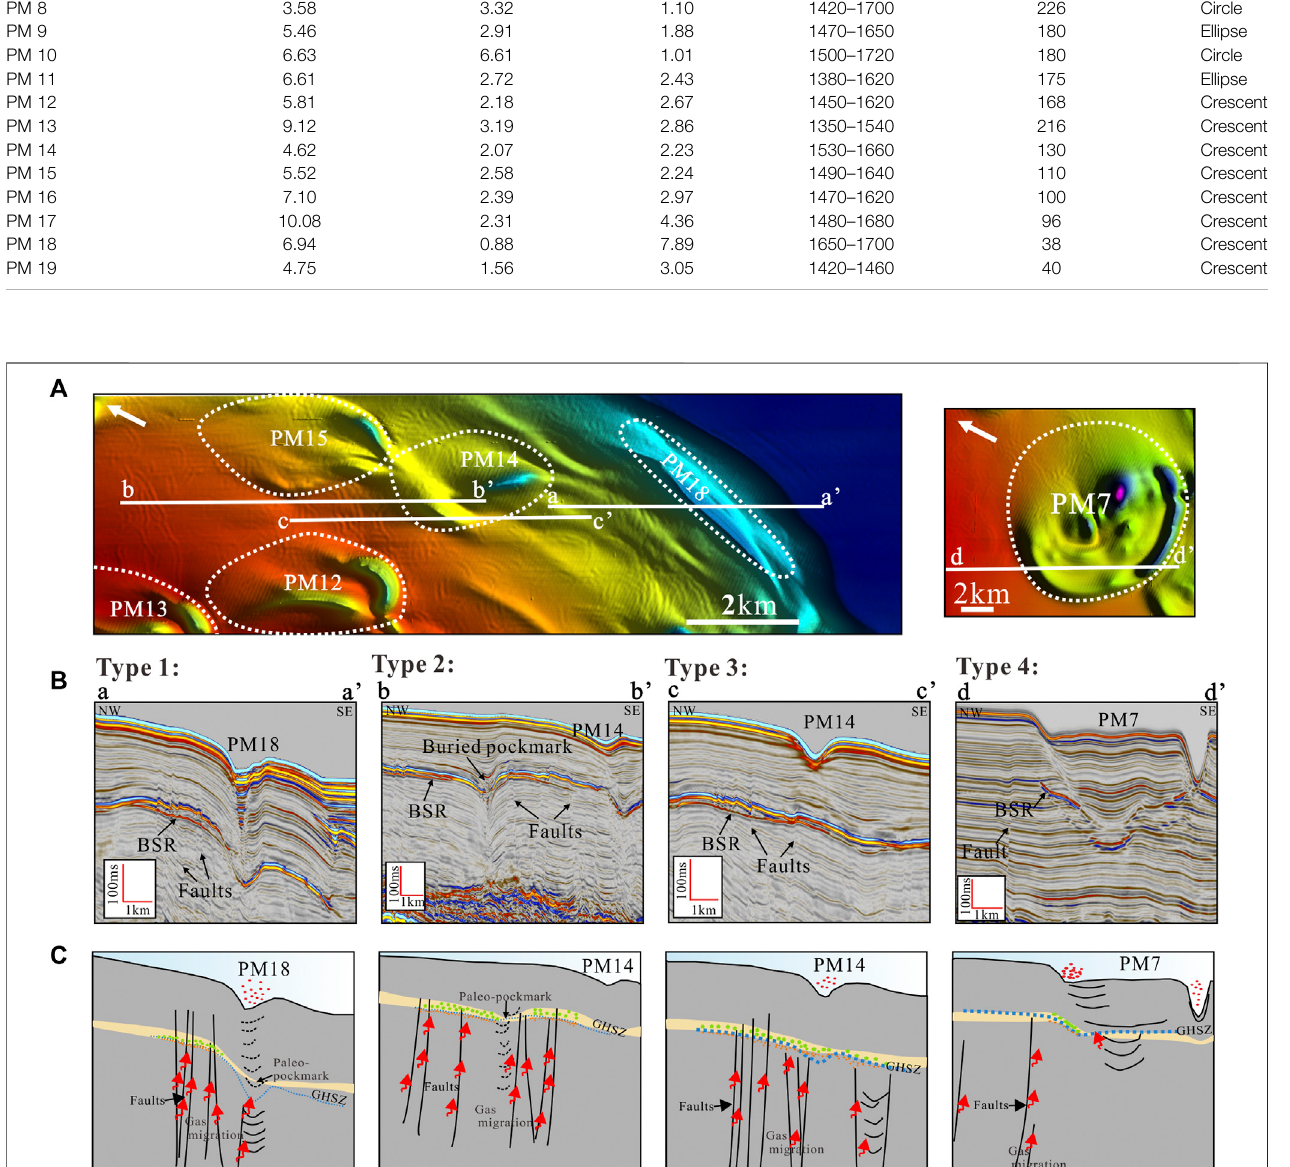
Frontiers in Earth Science |